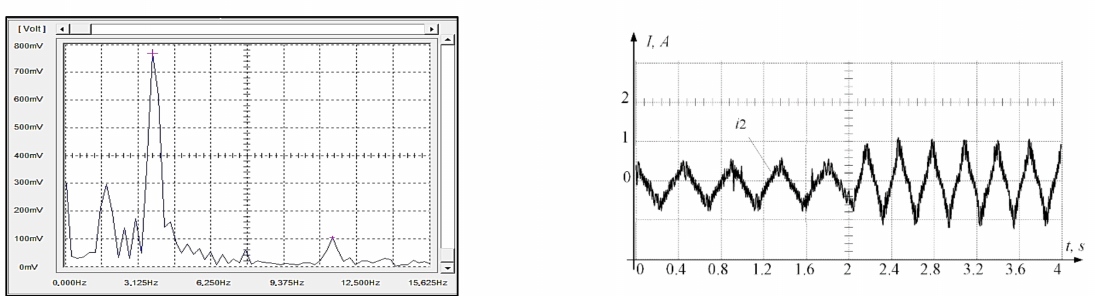
Figure 9. Rotor current in a DPF drive and its spectrum under load surge.